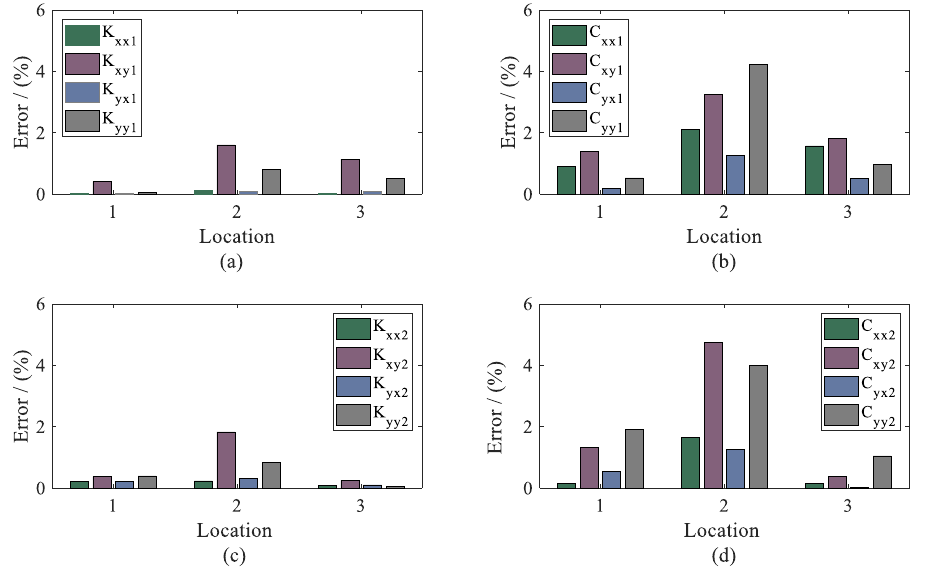
Figure 16. Error between the proposed and conventional method. ( a ) stiffness coefficients of bearing 1; ( b ) damping coefficients of bearing 1; ( c ) stiffness coefficients of bearing 2; ( d ) damping coefficients of bearing 2.